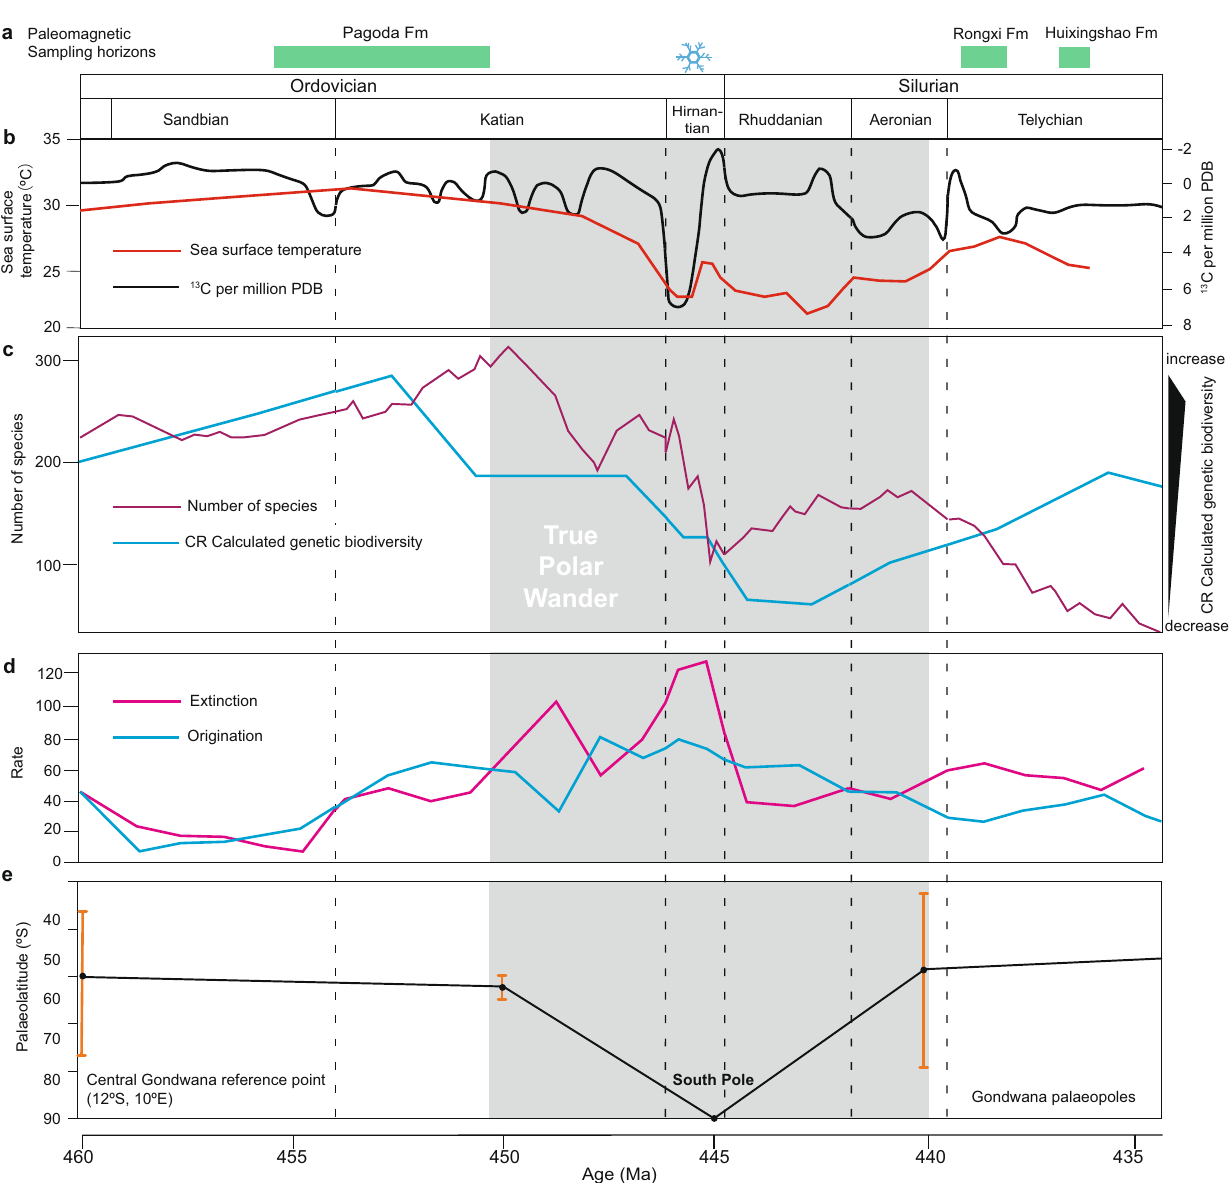
capture – recapture modeling. d Rates of origination (blue) and extinction (magenta) with 1 million year age binning from Deng et al. 11 . e Palaeolatitudinal variation of a reference point in central Gondwana (12°S, 10°E) calculated by using 460 – 430MaGondwanapalaeopoleslistedinSupplementaryTable2.Notethatthe 430Ma palaeolatitude is not displayed. Orange vertical bars are intervals of 95% con fi